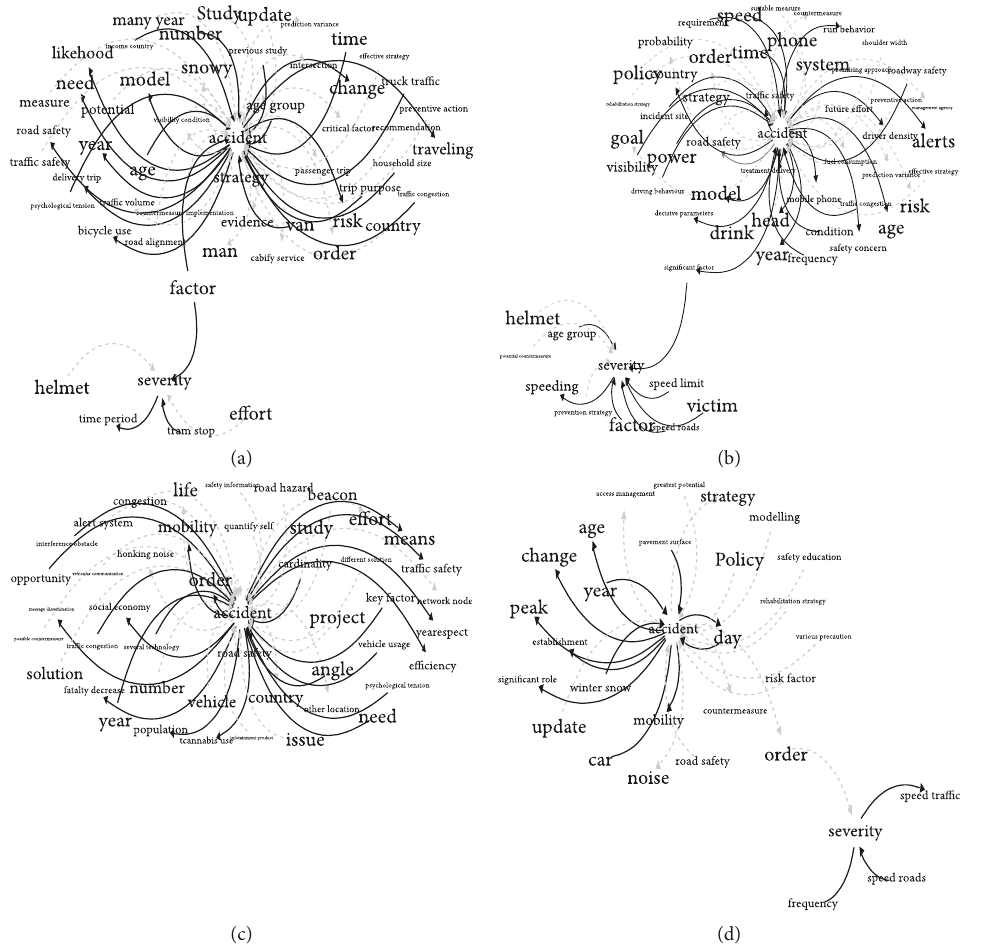
Figure 7: Variables related to the frequency and severity of road accidents for the (a) RTA +HA +SM, (b) RTA +HA +ML, (c) RTA+HA +SC, and (d) RTA +HA +GIS clusters. Here, solid dark arcs represent variables that contribute to the frequency and/or severity of road accidents, while gray arcs represent the variables that mitigate their frequency and/or